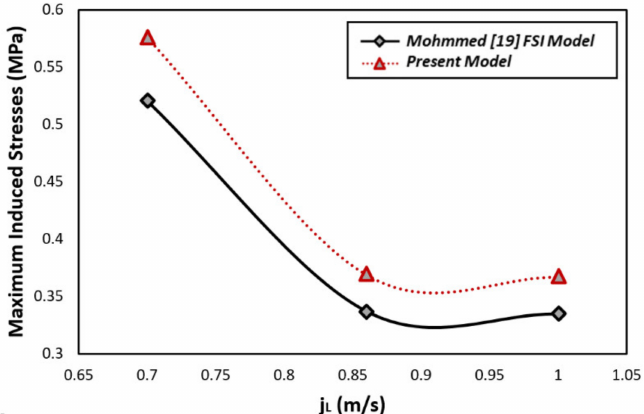
Figure 8. Quantitative validation of maximum induced stresses due to the effect of the slug charac- teristics of the air–water two-phase flow validation cases and comparison of FSI model of the present study against the FSI model of Mohmmed [19].